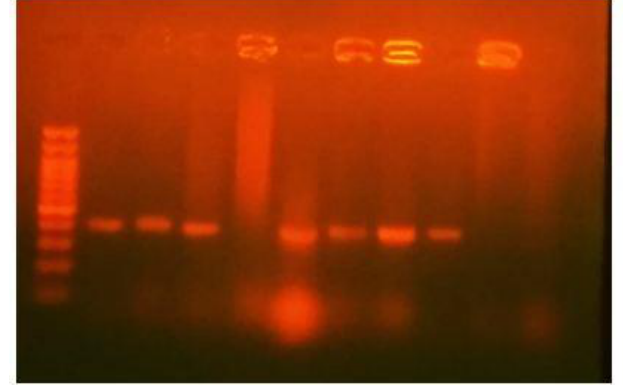
Fig.5: Agarose gel electrophoresis showing amplification of 397 bp fragment for 16 S rRNA gene of the Acinetobacter species isolates. Lane 1: 1 kb Ladder, Lanes(2,3,4,6,7,8,9): positive Acinetobacter species, Lanes(5,10): negative for Acinetobacter species.